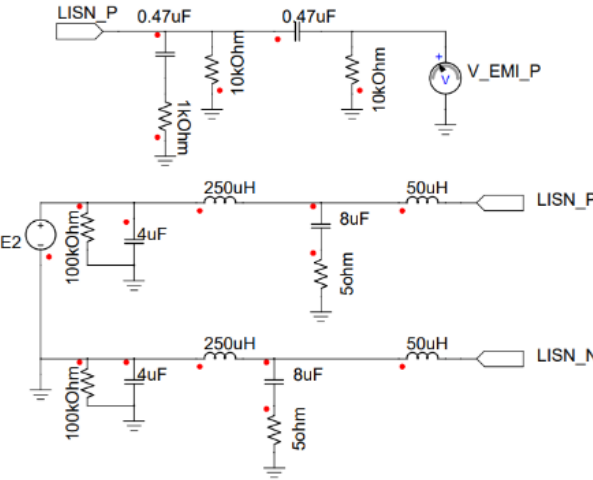
Figure 11. The electrical model of the LISN used in the time-domain simulation.